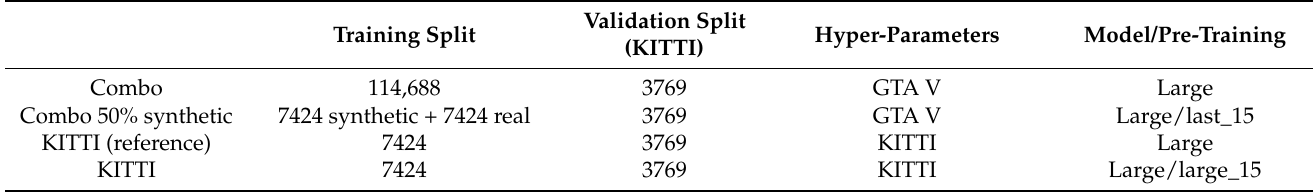
Table 4. Comparison between the KITTI dataset and datasets combining both KITTI and syn- thetic data.